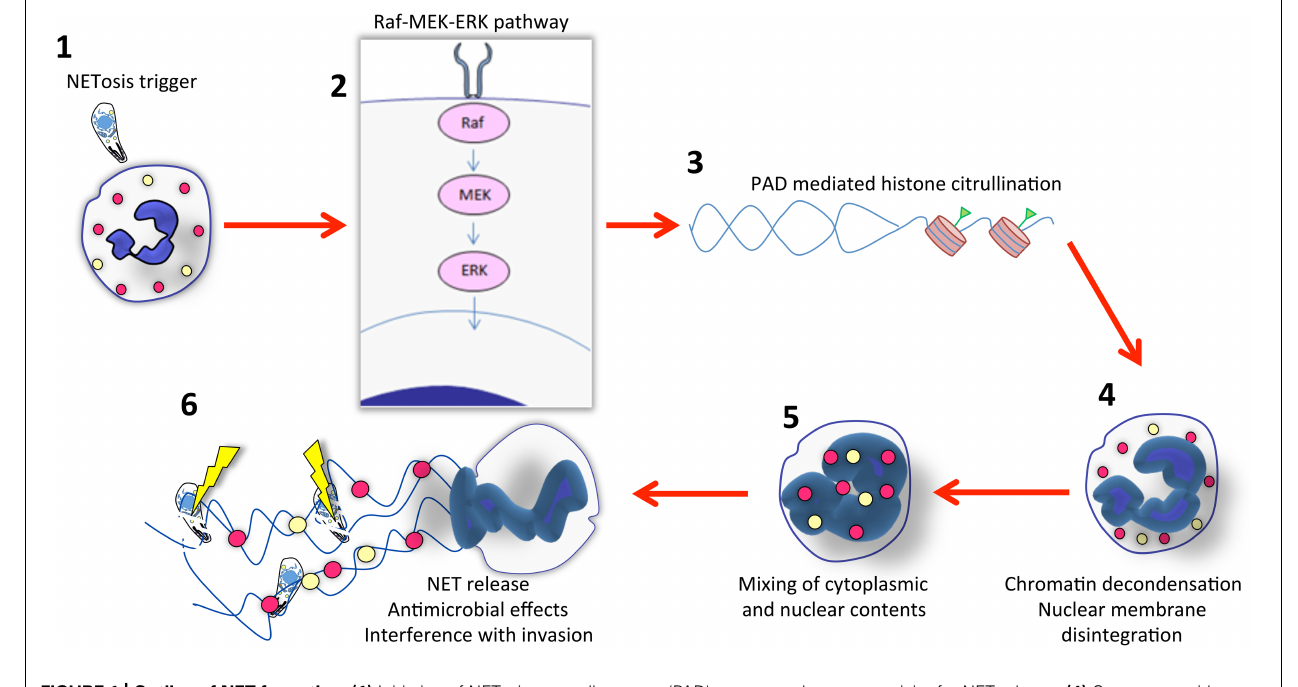
(PAD) appears to be a prerequisite for NET release. (4) Concurrent with chromatin decondensation, the nuclear membrane disintegrates. (5) This results in mixing of cytoplasmic, granule (yellow and red circles) and nuclear contents. (6) Finally, DNA with associated histones and granule molecules are released into the extracellular environment entrapping microbes in the vicinity. For protozoa such as Toxoplasma this results in some parasite killing, but the major effects of NETs may be to interfere with invasion.There is evidence that other protozoa such as Leishmania donovani possess mechanisms to avoid NET-mediated